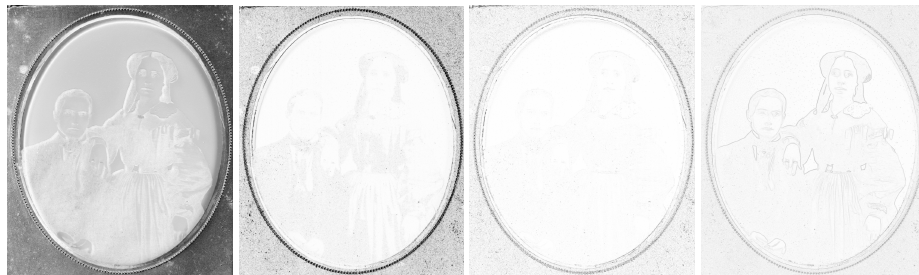
Figure 13. Grayscale images of ambrotype, daguerreotype, and tintype scanned in LLa mode.